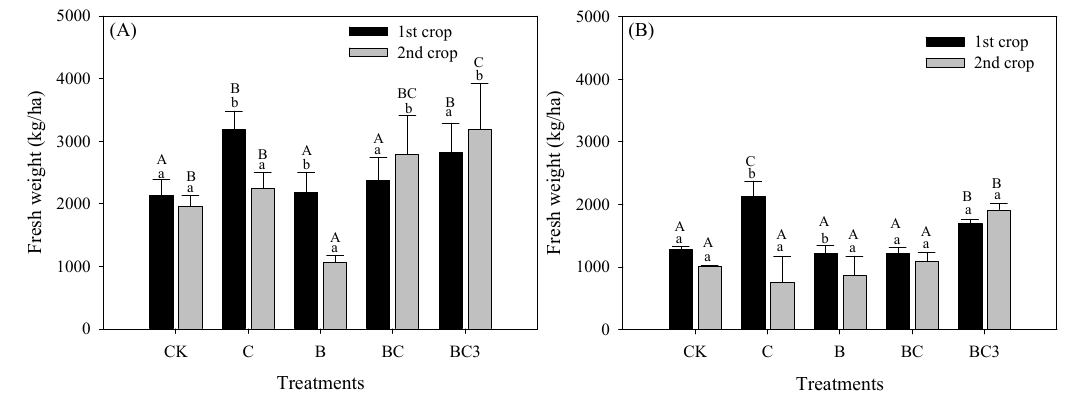
Figure 5. Effect of biochar compound materials on crop yield during the experiment ( A ) sandy soil ( B ) clay soil. Lowercase letters represent comparisons between the same treatment during different crop periods ( p < 0.05); Uppercase letters represent comparisons between different treatments during the same crop period ( p < 0.05).